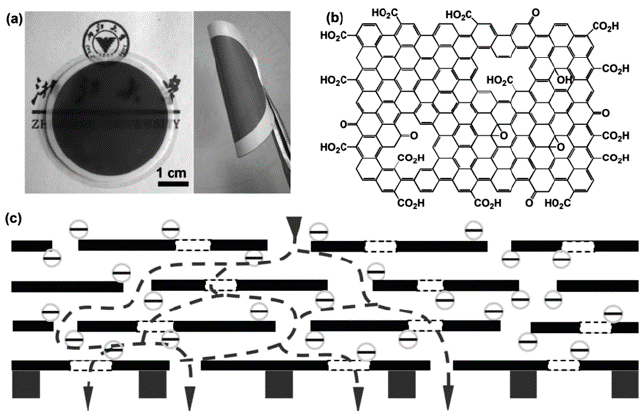
Figure 7. ( a ) Photographs of ultrathin graphene nanofiltration membranes (uGNM) coated on an anodic aluminum oxide (AAO) disk and a twisted uGNM coated on a PVDF membrane; ( b ) the structure of the base-washed GO; ( c ) schematic view for possible permeation route. Figures are reprinted with permission from Ref. [34]. Copyright Wiley-VCH, 2013.